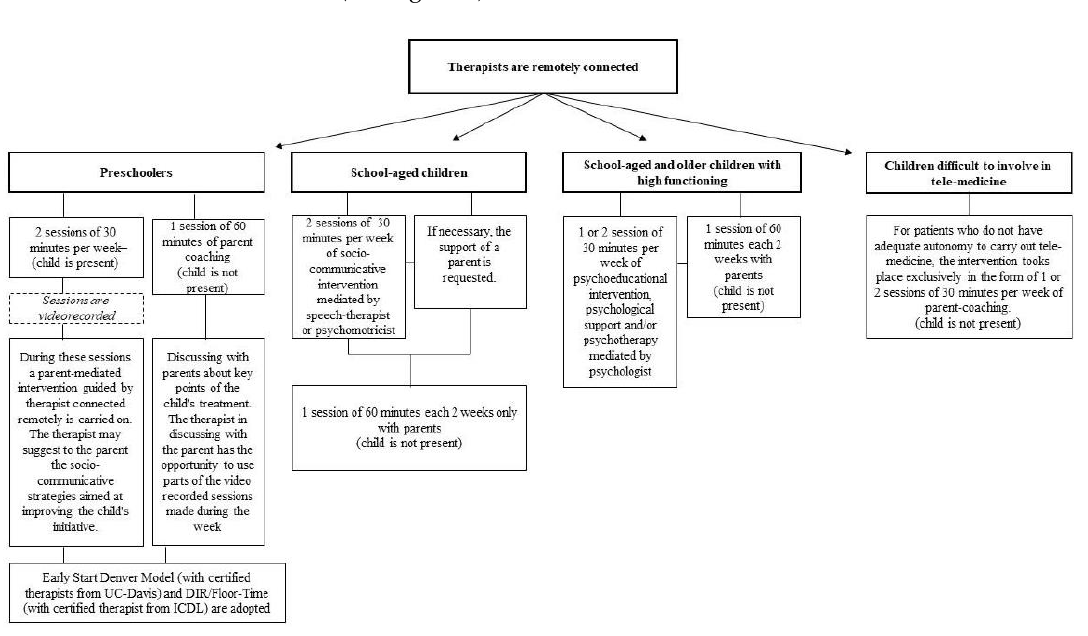
Figure 2. Working model for intervention.